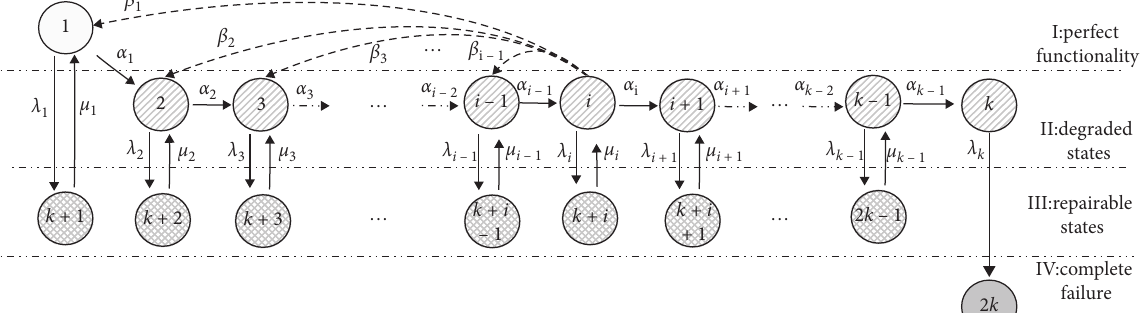
Figure 1: State transition diagram of the